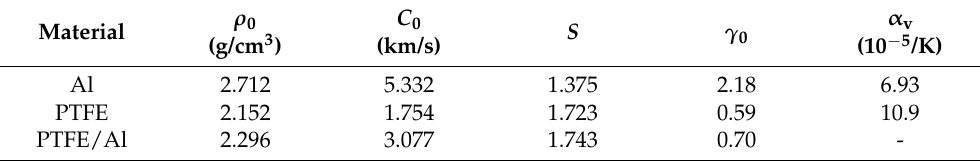
Table 2. The parameters of elemental materials.